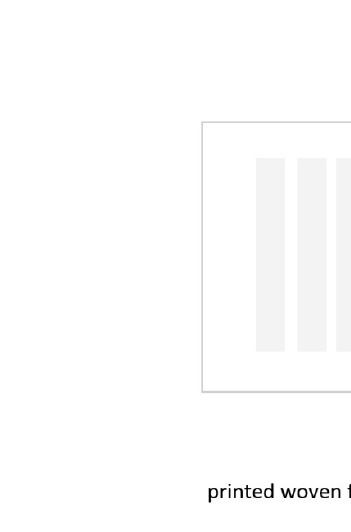
Figure 1. Schematic illustration of the screen-printing and irradiation process of flat woven fabric.